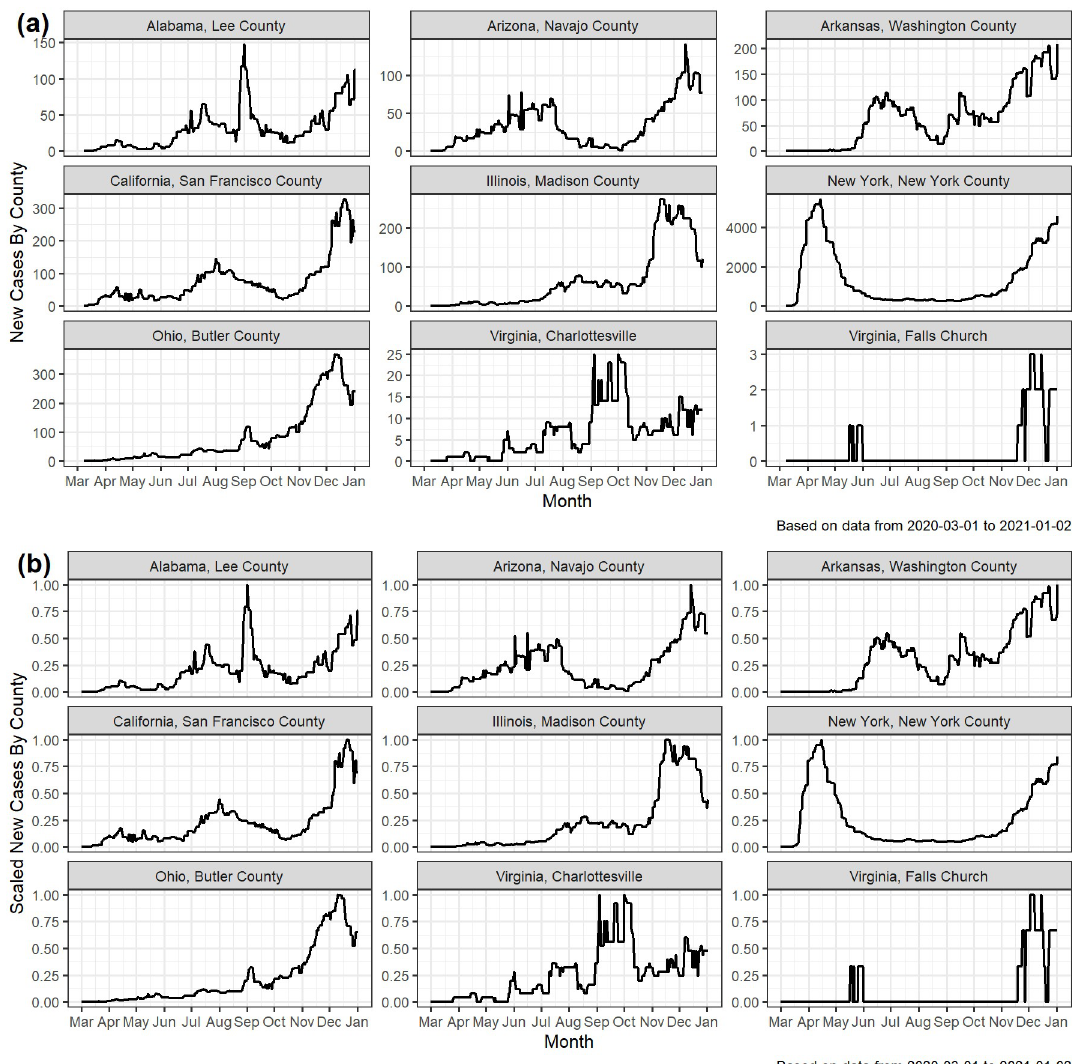
Fig 2. The 7-day moving medians of the (a) number of new daily cases, and (b) scaled [0-1] daily cases for a sample of nine U.S.